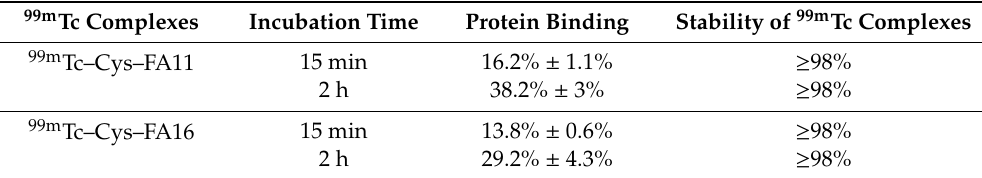
Table 3. In vitro protein binding and plasma stability of 99m Tc–Cys–FA11 and 99m Tc–Cys–FA16 at 37 ◦ C.